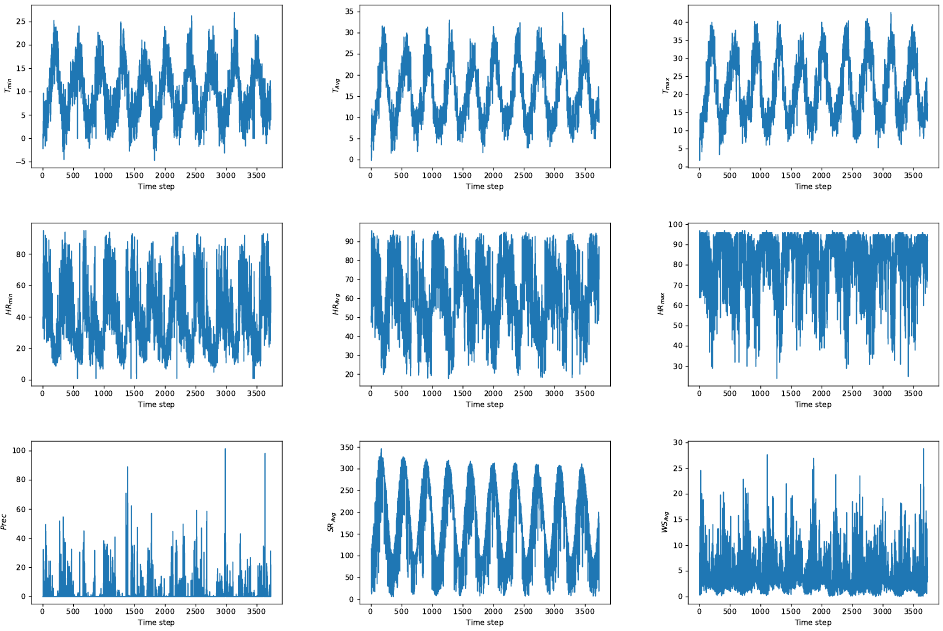
Figure 6. Fadagosa